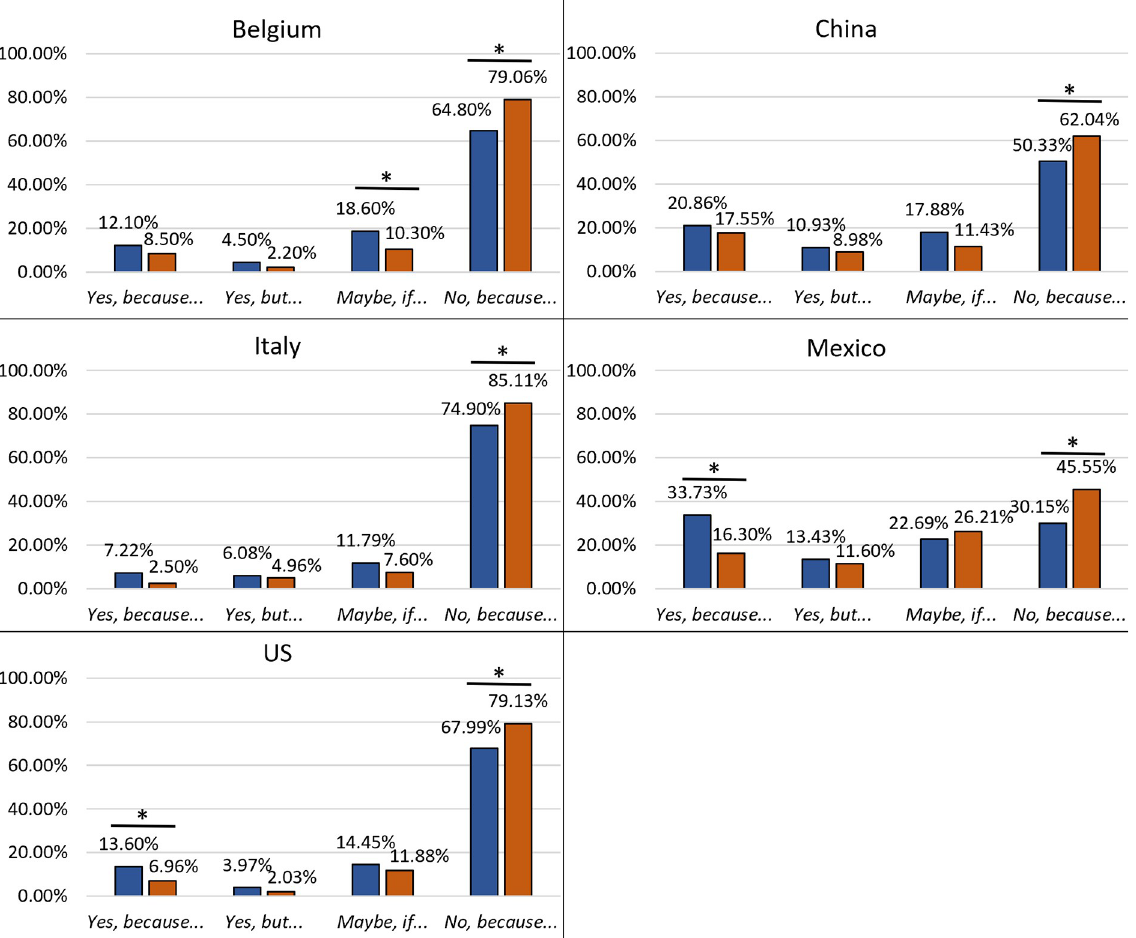
Fig 2. Effects of gender on the acceptance level of the inclusion of whole mealworms in the diet in different countries. Male: blue columns; Female: orange columns. � Significant difference assessed by Chi 2 test of homogeneity with post hoc test (z-test of two proportions) with Bonferroni’s correction ( P <